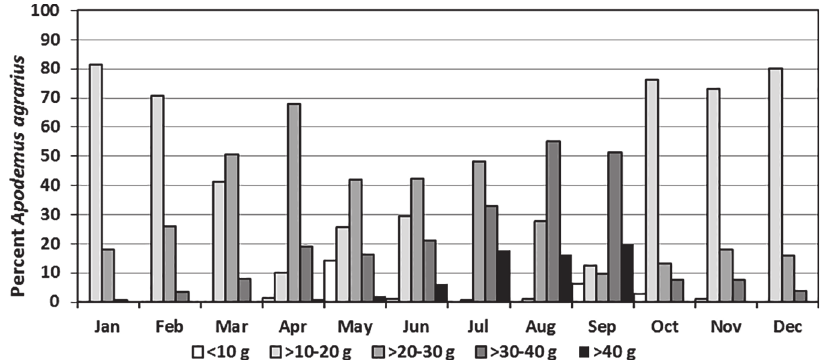
Fig 3. Monthly percent of A . agrarius captured at Nightmare Range 1 , by weight, from January 2008-December 2009. 1 One each of Micromys minutus and Myodes regulus were seropositive for hantaviruses during January 2009 when the hantavirus seropositive rate for Apodemus agrarius was 5.1%. One Crocidura lasiura was seropositive for Imjin virus during June.